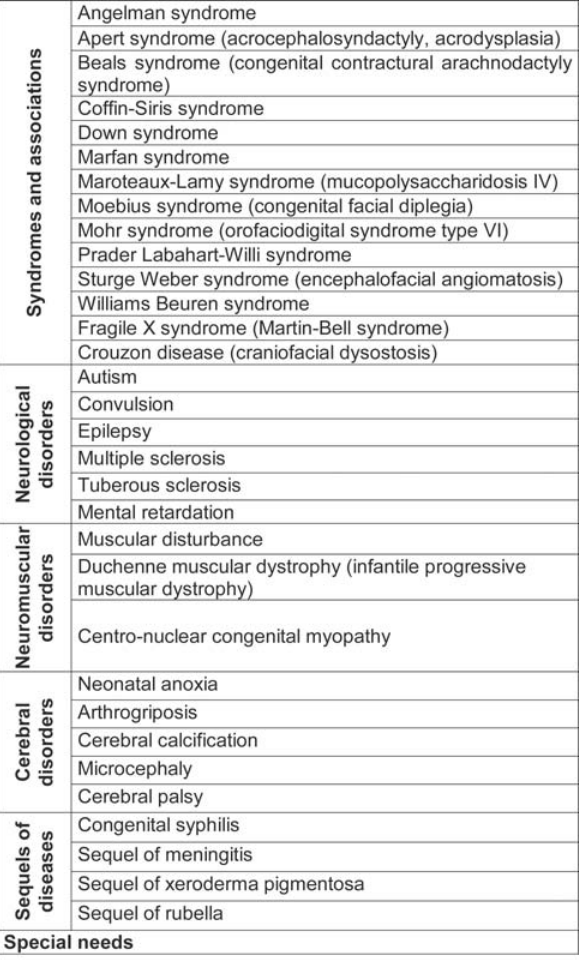
FIGURE 1- Subdivision of the groups of patients